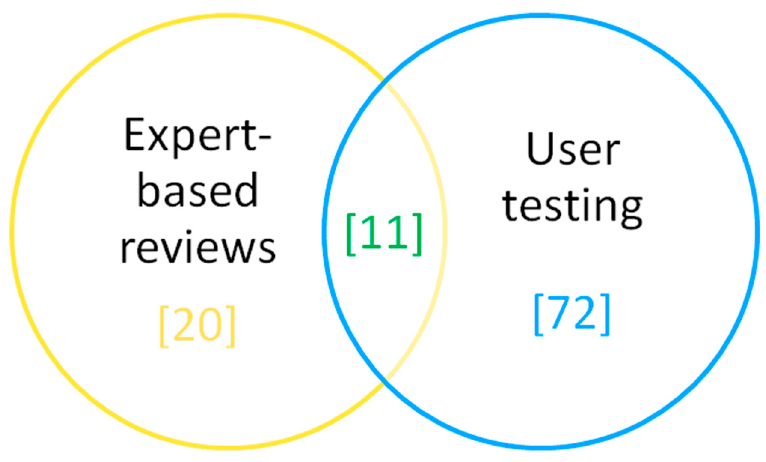
Figure 4. Distribution of metrics to specific methods.